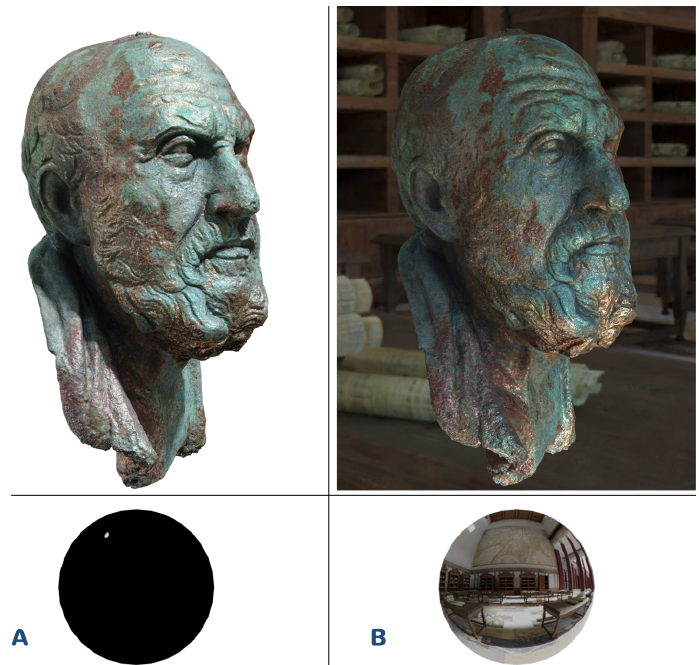
Figure 17. Chrysippus model rendered using a physically, path tracing, based production renderer (Cycles within Blender 2.93) and environment lights used: ( A ) a spot light similar to the museum exposition and ( B ) a reconstructed environment (E.Demetrescu) of the Forum of Pacis.